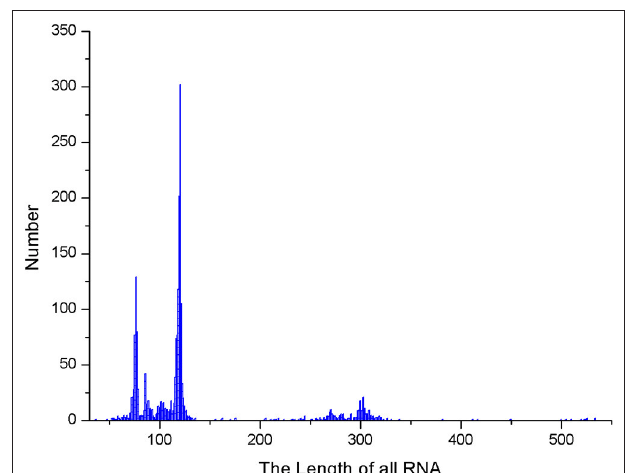
FIGURE 9 | Stem length statistics in the data set.